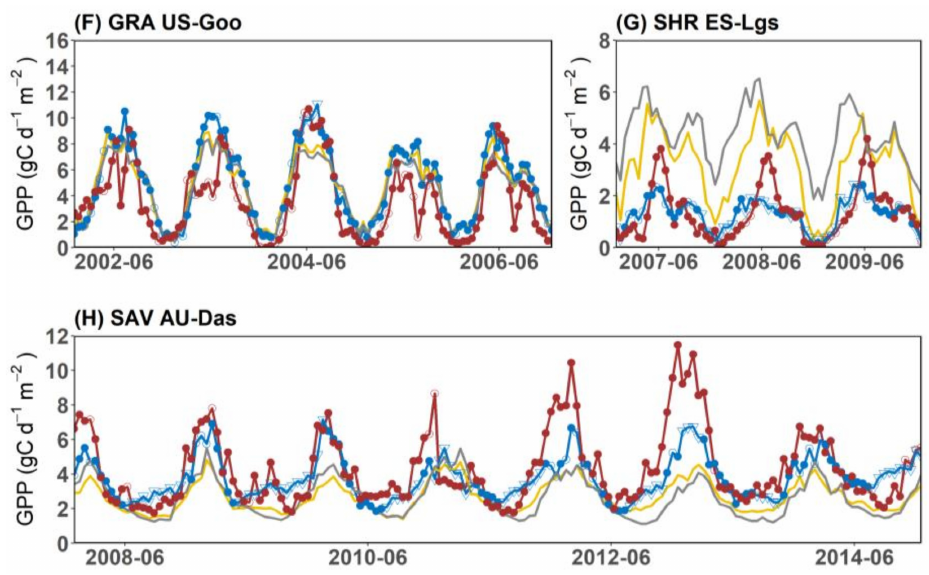
Figure 4. Time series of GPP (flux), GPP L (Landsat), GPP M (MODIS), and GPP A (AVHRR) at eight typical vegetation sites. The symbols • , , and (cid:53) in GPP L represent the GPP driven by observed (cid:35) short-term gap-filled reconstructed NDVI and long-term gap-filled reconstructed NDVI, respectively. The symbols • and in the flux-tower-based GPP (red curve) are the observed GPP and gap-filled (cid:35) GPP,